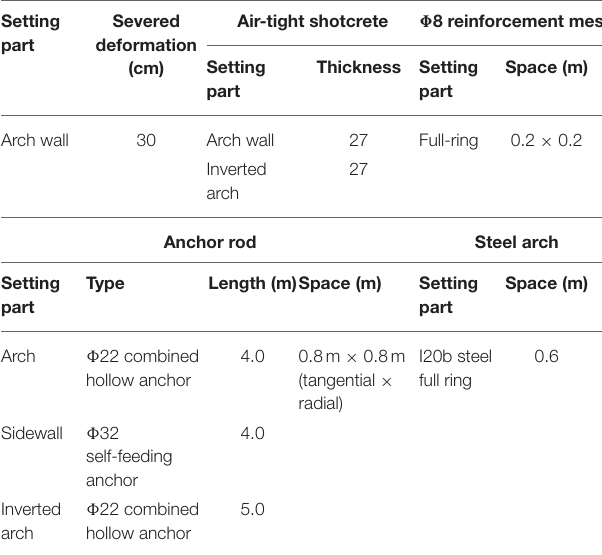
TABLE 2 | Parameters of type III composite